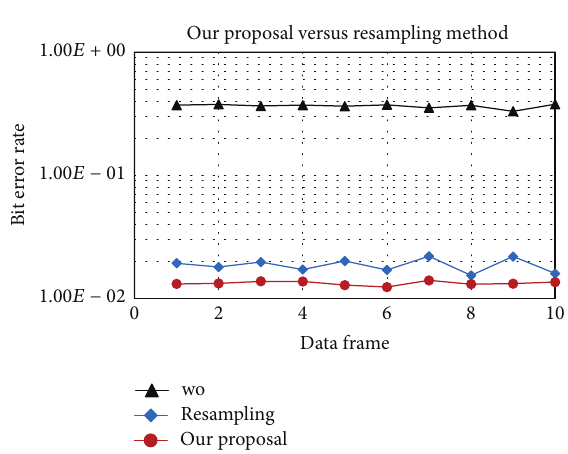
Figure 7: 16QAM, proposed method versus the resampling based method.